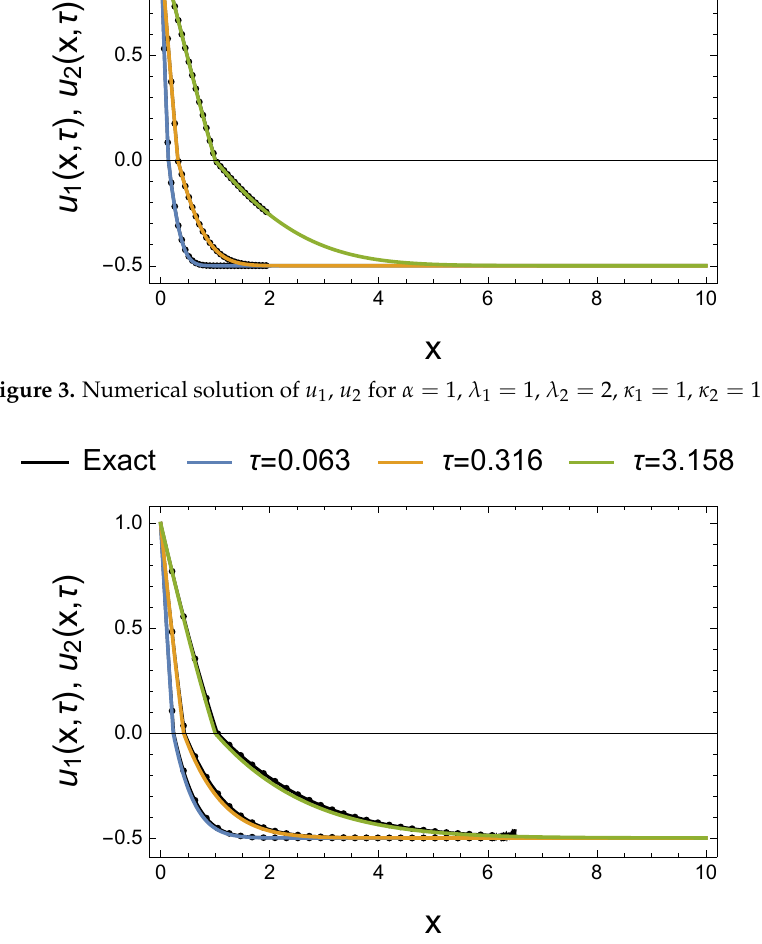
Figure 4. Numerical solution of u 1 , u 2 for α = 0.75, λ 1 = 1, λ 2 = 2, κ 1 = 1, κ 2 = 1.